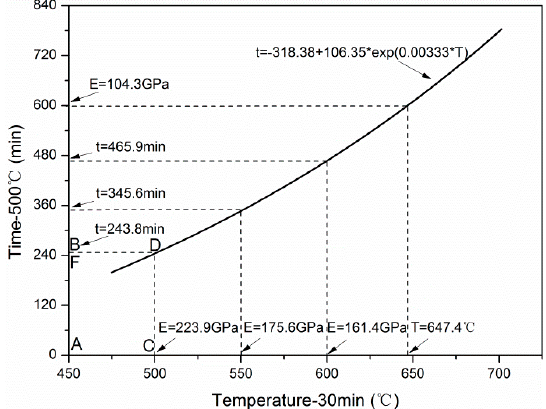
Figure 19. Time–temperature equivalence equation .